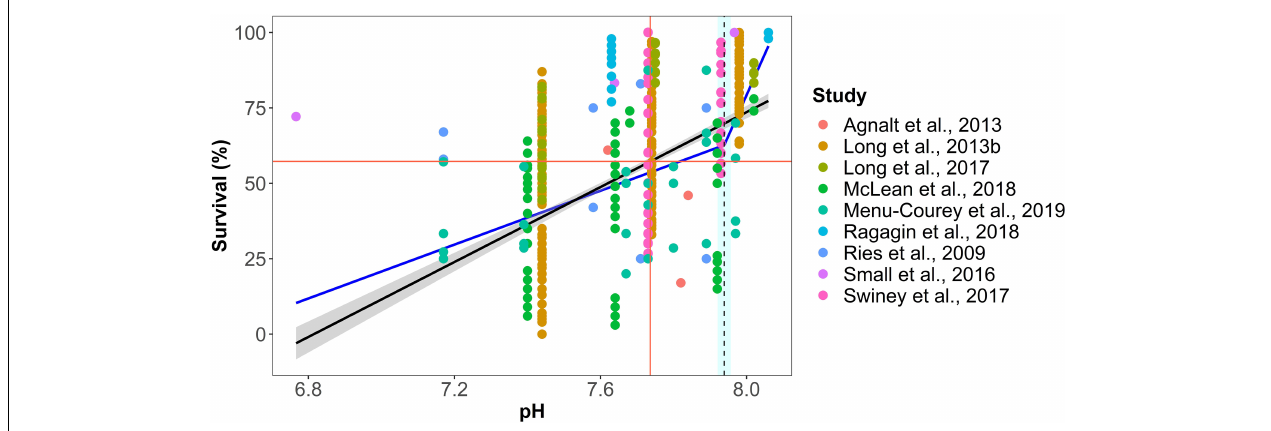
FIGURE 4 | Example of breakpoint and least square regression analysis of experimental stress-response from combined studies of juvenile decapod mortality (pH breakpoint = 7.75, 25% LSR = 7.84, p -value ≤ 0.0001). Black line indicates linear best-fit line with the 95 th percentile confidence interval of the least-squares regression ( r 2 = 0.24, p -value < 0.0001; red cross indicates where the predicted response has decreased by 25% of the difference between maximum and minimum predicted values; blue line is piecewise linear regression fit; dotted line is the breakpoint; gray area indicates standard error for the line, and light blue area signifies 95% confidence interval for the breakpoint. Regression statistics are given for each statistical analysis. Color of data points denotes source of data from cited